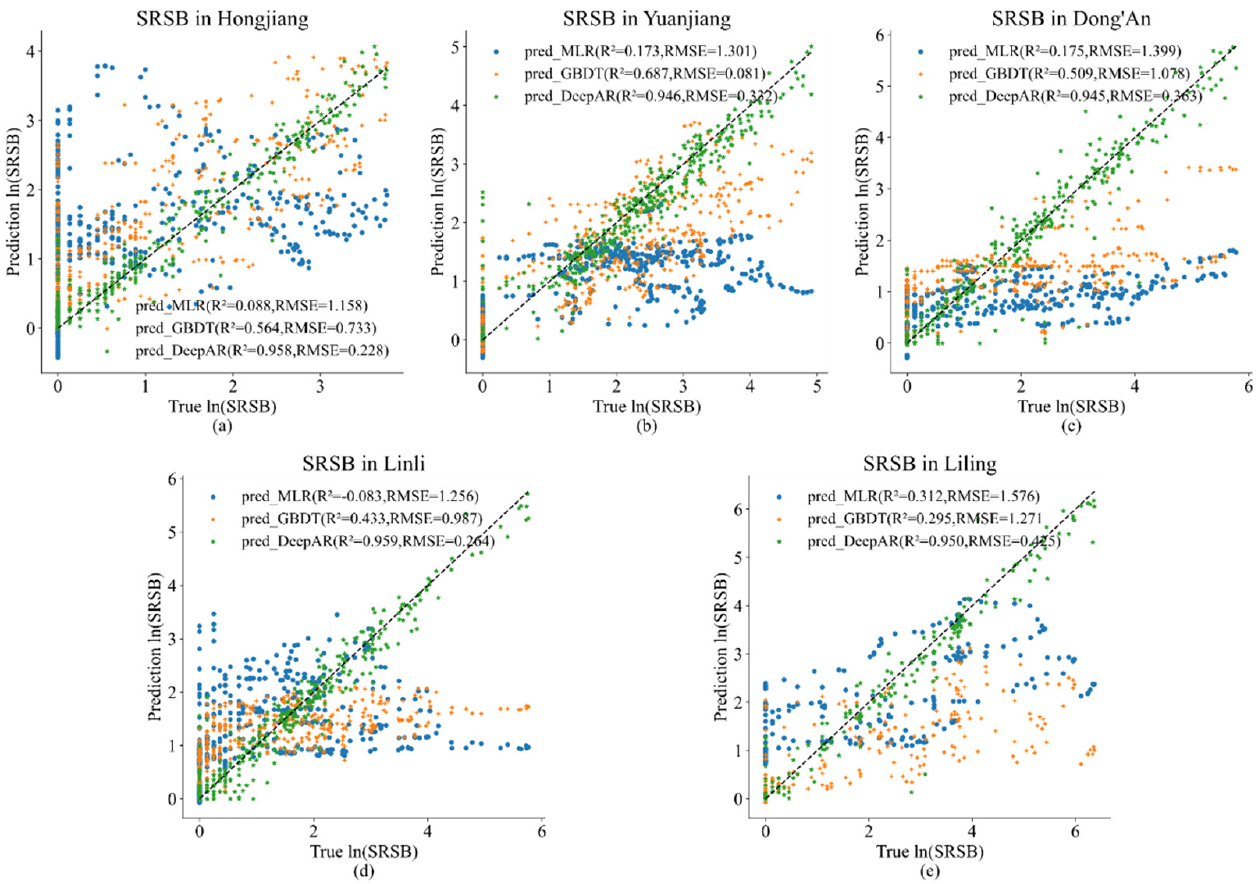
Figure 6. Actual versus predicted natural log-transformed ln (SRSB) in ( a ) Hongjiang, ( b ) Yuanjiang, ( c ) Dong’an, ( d ) Linli, and ( e ) Liling.